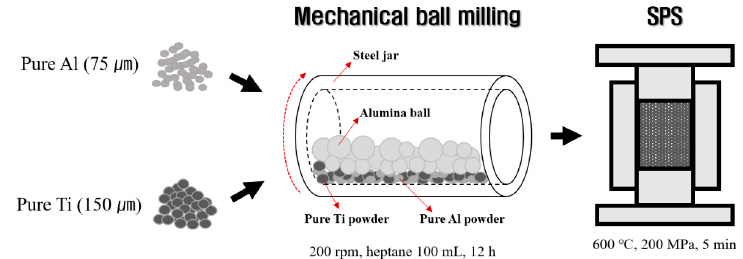
Figure 1. The mimetic diagram of the fabrication procedure for Al-Ti composites.